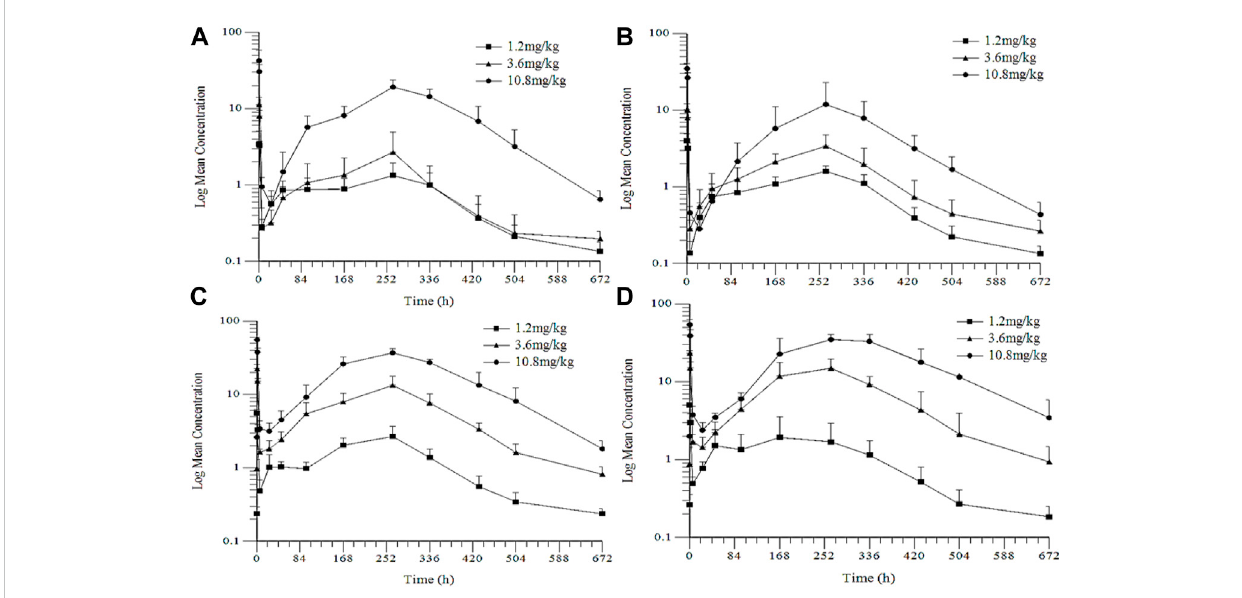
FIGURE 5 Mean Plasma Concentration-Time Pro fi lesof GoserelininTK Study in Rats (A) and (C) :the 1st and the4th dose infemale rats (B) and (D) :the1st and 4th dose in male rats.